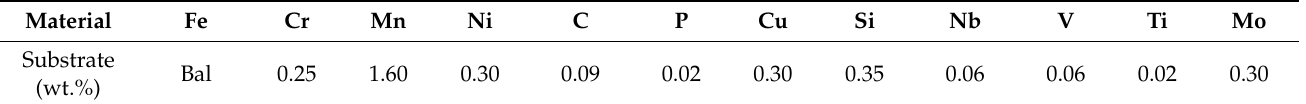
Table 1. Chemical composition of X65 steel